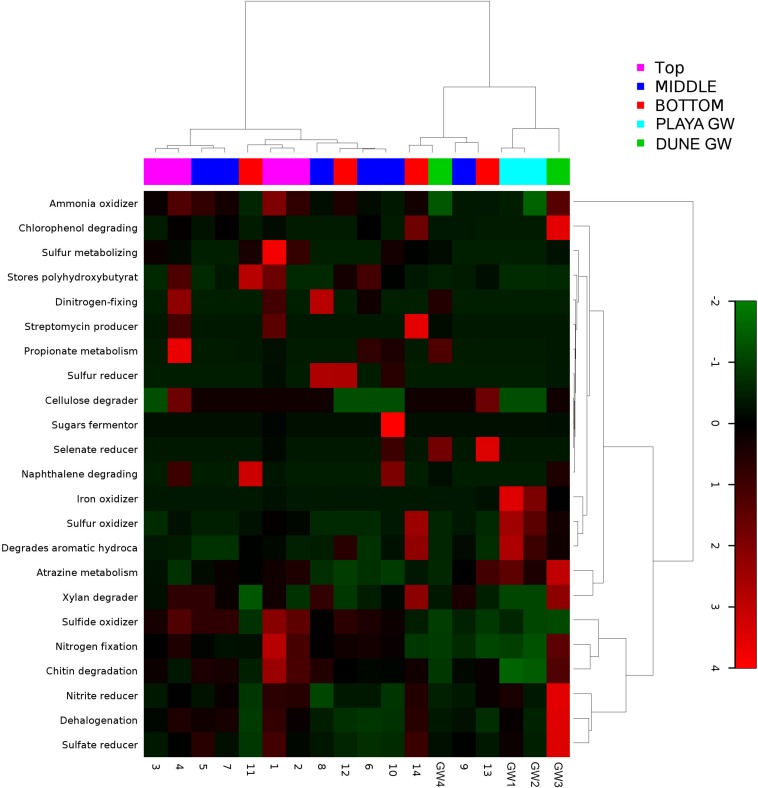
Heatmap of 23 bacterial metabolic potentials constructed from 16S rRNA-based taxonomic identities. The color scale represents relative intensity of each metabolic pathway, with red being the highest and the green the lowest.